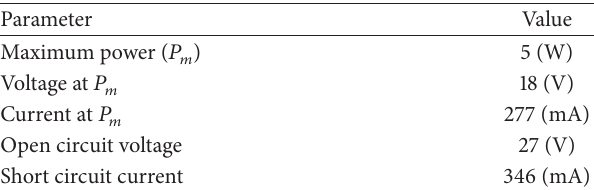
Table 1: Solar cell description.